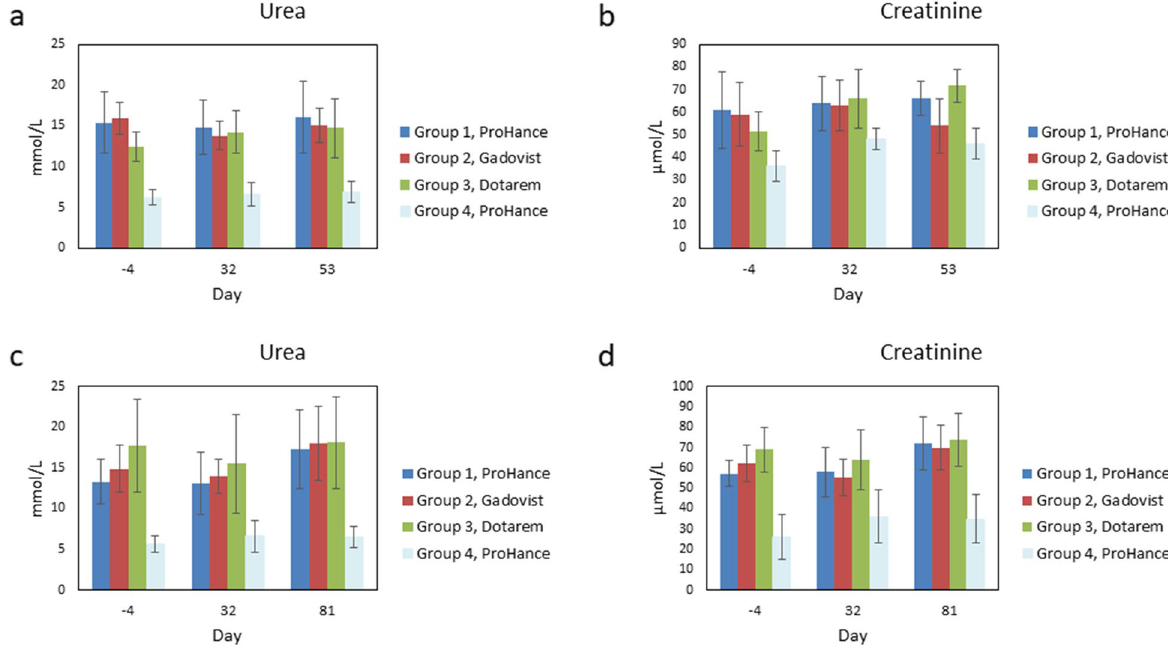
Fig. 2 Plasma urea and creatinine levels. Urea and creatinine levels (mean contrast agent administration (day -4), immediately after the end of dosing (day 32) and at scheduled sacrifices: 28 days post-treatment (day 53, a , b ) or 56 days post-treatment (day 81, c , d ). The error bars represent the standard deviation of measurements within the groups (group 1, gadoteridol, n 8 in a to d ; group 2, gadobutrol, n = n 5 in a to d =